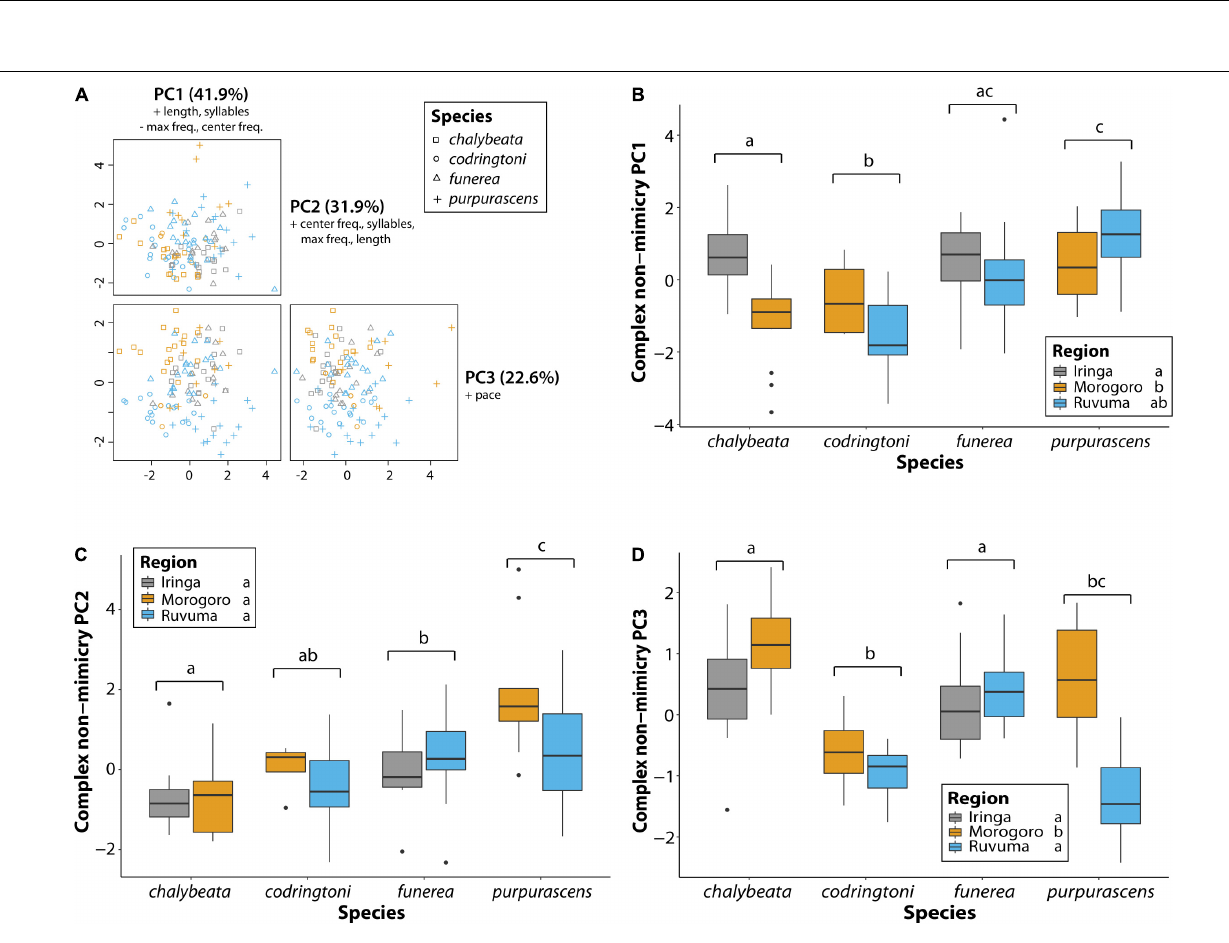
FIGURE 5 | Variation in general characteristics of non-mimicry songs between indigobird species and sampled regions. Song length, number of syllables, pace, center frequency, and maximum frequency measurements were collapsed via a principal component analysis (A) . Variables with loadings > 0.4 ( + ) or < − 0.4 ( − ) are indicated for each principal component. Variation among species and regions in the first three PC axes is shown in panels (B–D) . Significant differences between species (adjusted P < 0.05) are indicated by different lowercase letters above the brackets for each species. Similarly, regions labeled with different lowercase letters were significantly different in post hoc